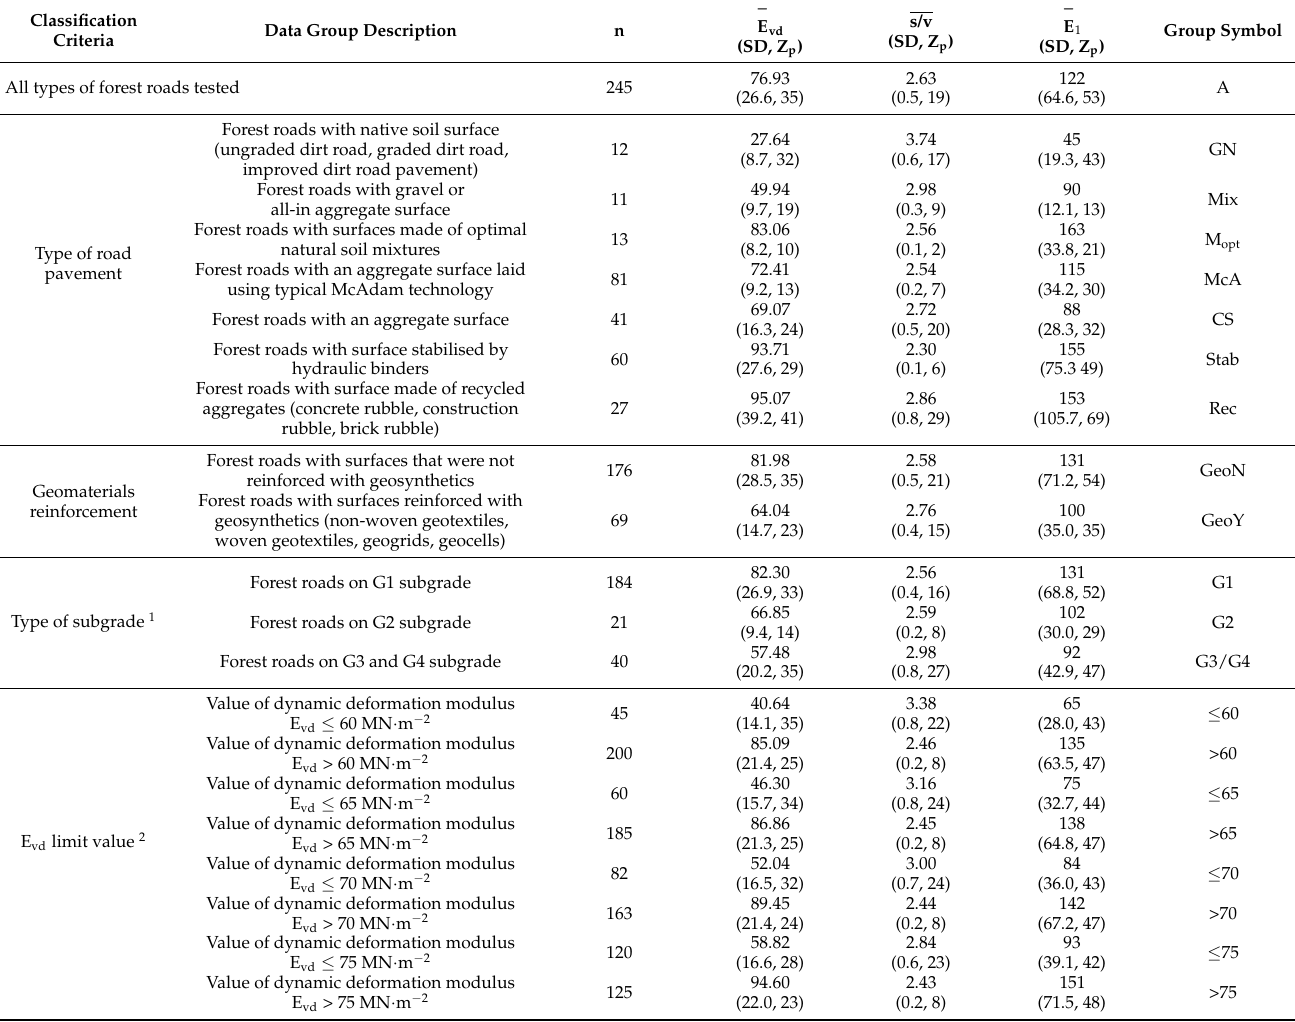
Table 2. Variants of the data sets that were subjected to the regression analysis, together with their numbers (n), the mean values of the dynamic deformation modulus (E vd ) [MN · m − 2 ], the s/v ratio (cid:16) (cid:17) s/v [ms] and the primary deformation modulus (E 1 ) [MN · m − 2